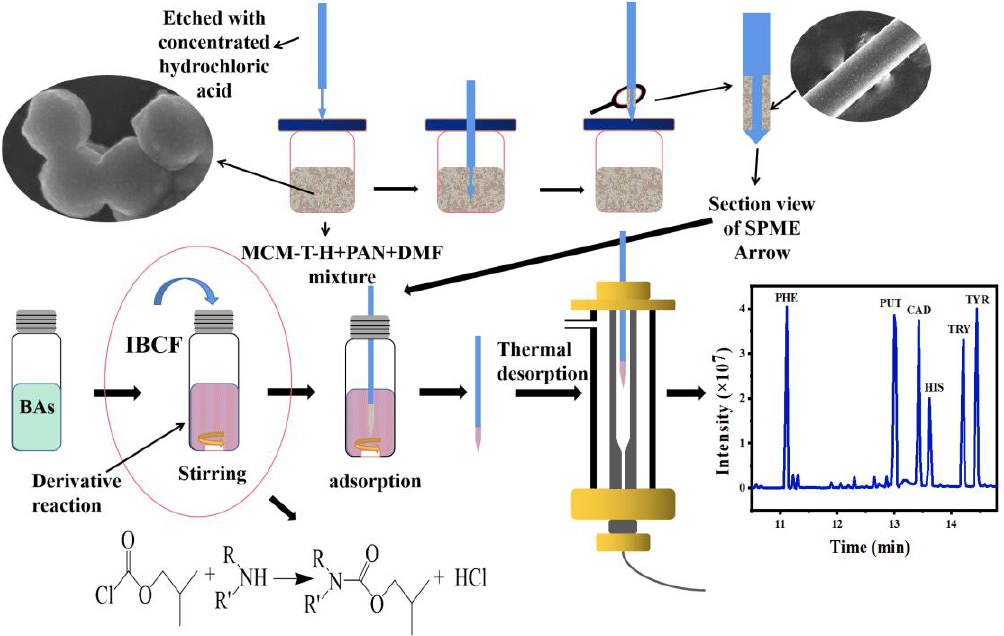
Figure 1. Schematic illustration of an SPME Arrow GC–MS method for biogenic amines detection.